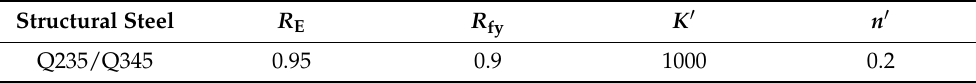
Table 1. Proposed material parameters for Q235 and Q345 structural steels.